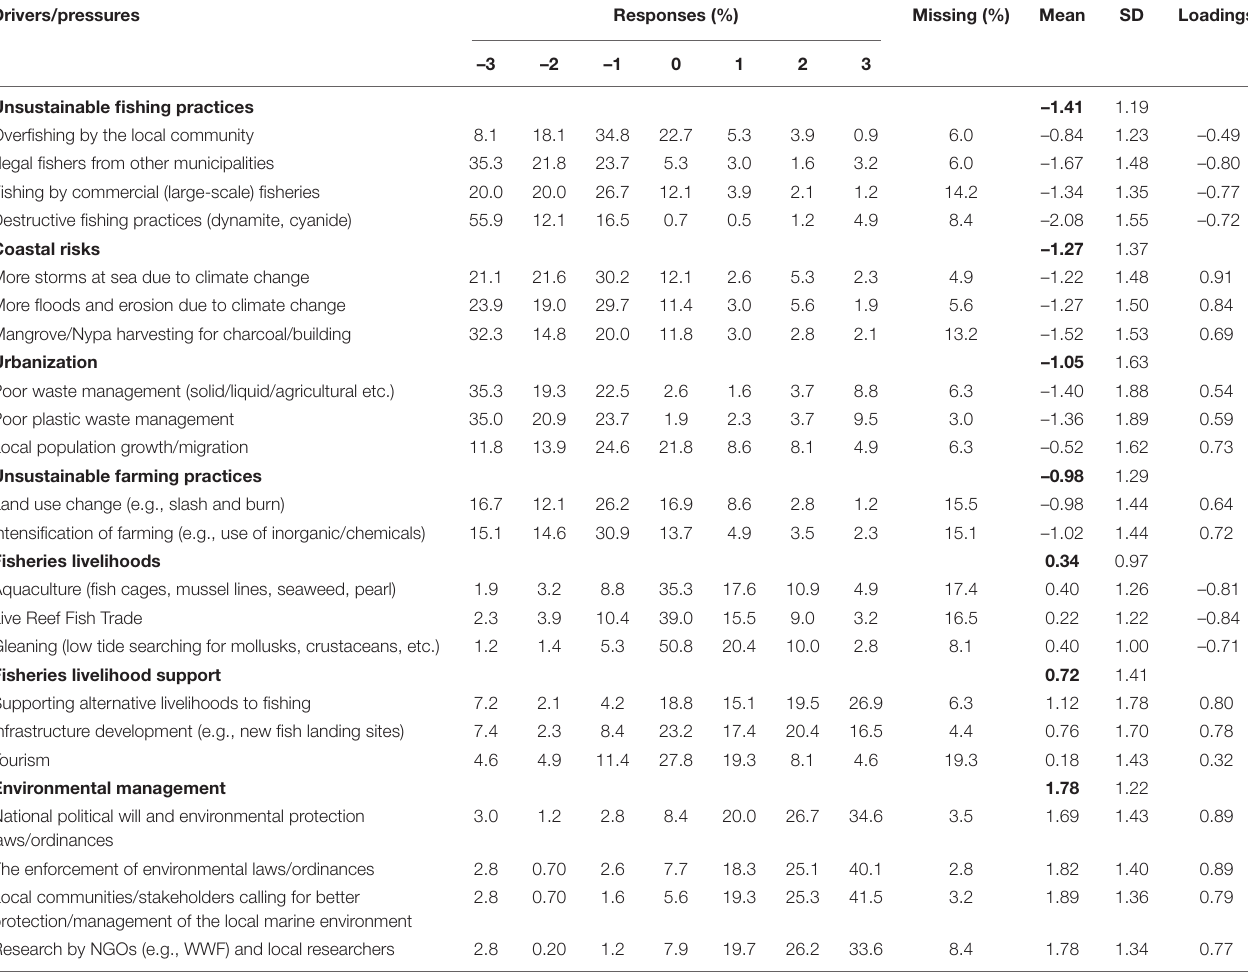
TABLE 2 | Local perceptions from the community survey of the drivers/pressures on the coastal marine environment of Palawan, Philippines. Drivers/pressures Responses (%) Missing (%) Mean SD